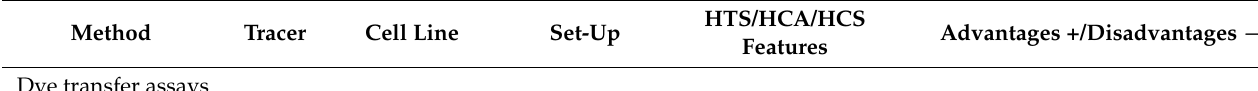
Table 2. Setups compatible for HTS and/or HCA/HCS of gap junctional intercellular communication (GJIC) (adapted from